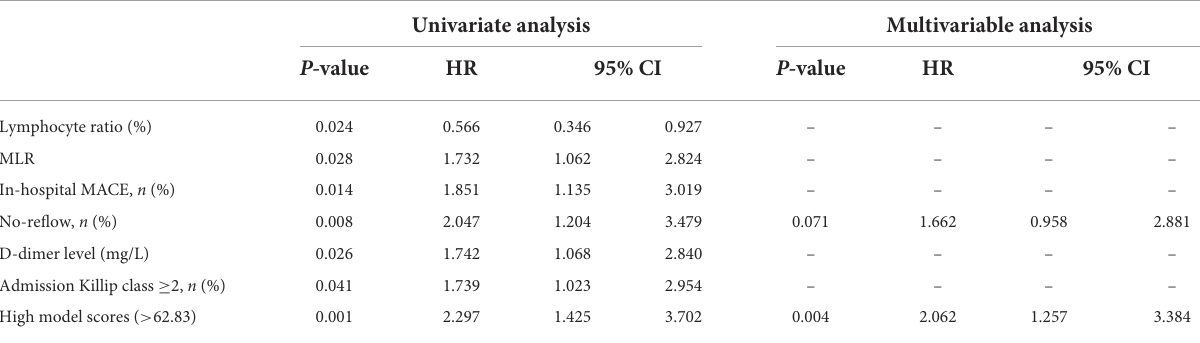
TABLE 4 The Cox proportional hazard regression model was used to determine the independent risk factors for the occurrence of MACE at 1-year post-discharge among patients with STEMI. Cox survival analysis of the predictors of MACE